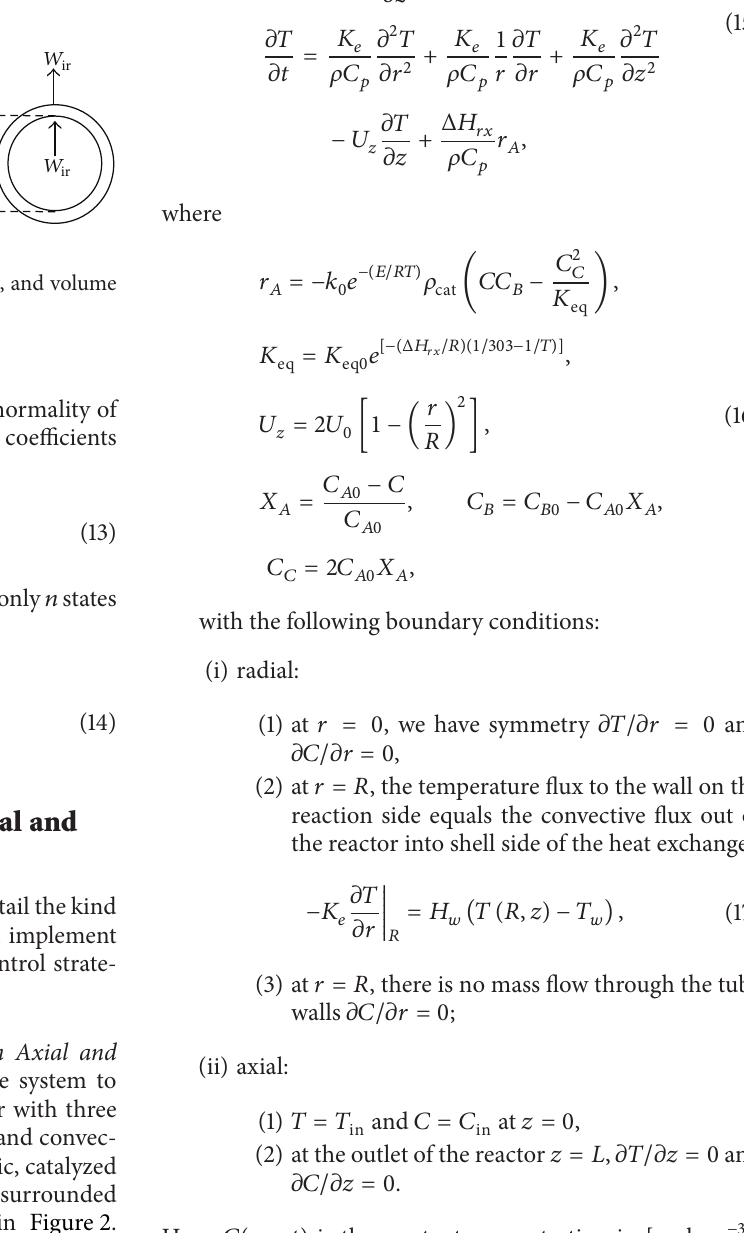
Figure 2: Tubular chemical reactor with 3 cooling/heating jackets.